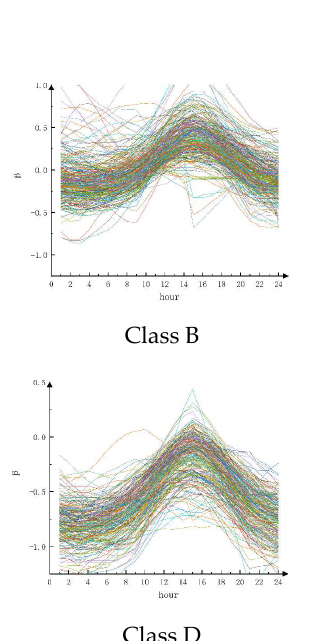
Figure 3. Beijing Figure 3. Beijing β syn classification.